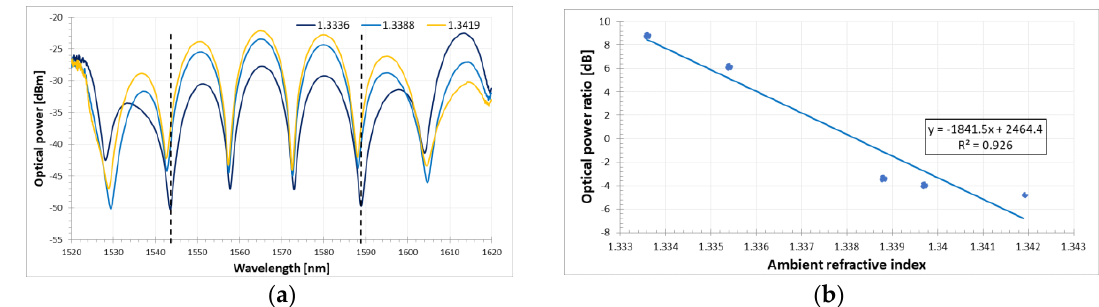
Figure 5. ( a ) Output transmission spectra of FLM-DRLPG structure for different ambient RI values at room temperature T = 23 °C and ( b ) sensor response for optical power ratio between the two peaks marked with dashed lines in ( a ).